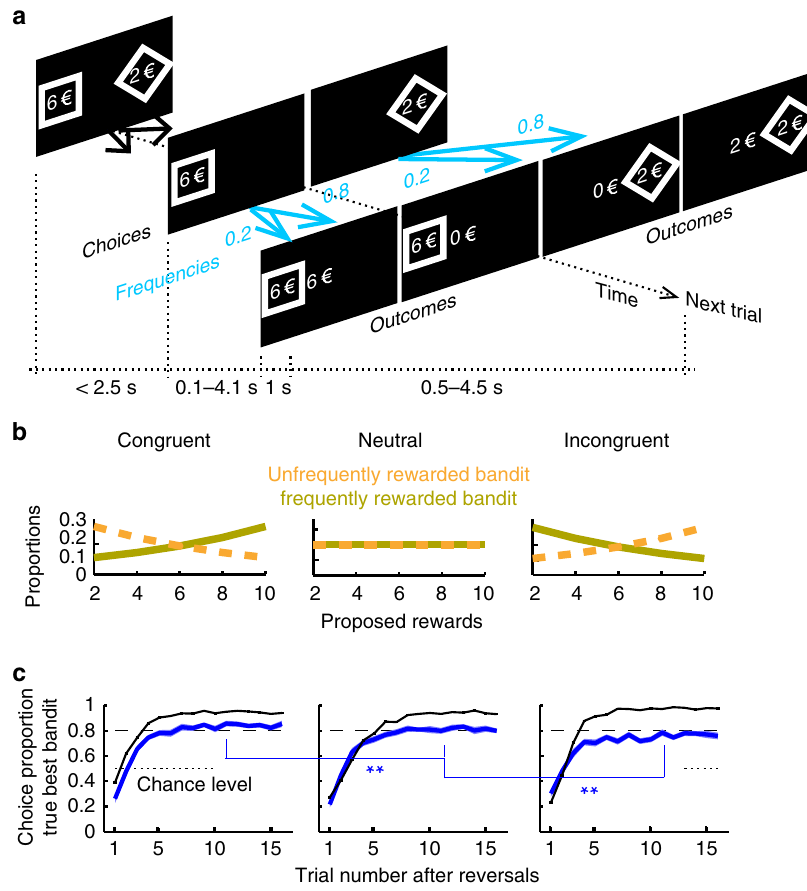
Fig. 1 Behavioural protocol. a trial structure. A square and diamond one-armed bandit with the offered rewards (euros) were presented on the screen (maximal duration: 2.5 s) until participants chose one bandit by pressing one response button. The chosen bandit remained on display. A feedback centred on the screen was then presented to reveal the bandit outcome (duration 1 s). One bandit led to proposed rewards (±1 € ) more frequently (blue arrows 80% vs. 20%) but this advantage reversed episodically. The next trial started with the presentation of both bandits again. Response-feedback onset asynchronies and intertrial intervals were uniformly and independently jittered (ranges: 0.1 – 4.1 s and 0.5 – 4.5 s, resp.). b Proposed rewards were biased in opposite directions in the congruent and incongruent condition (exponential biases: slope = ±0.13). c Proportions of choosing true best bandits (maximising reward frequencies x proposed rewards) following reversals. Mean proportions over participants (blue, ±s.e.m, N = 22) and for optimal model OPT (black line) are shown in the congruent, neutral and incongruent condition. Dashed line corresponds to the 80% reward frequency. ** p < 0.01